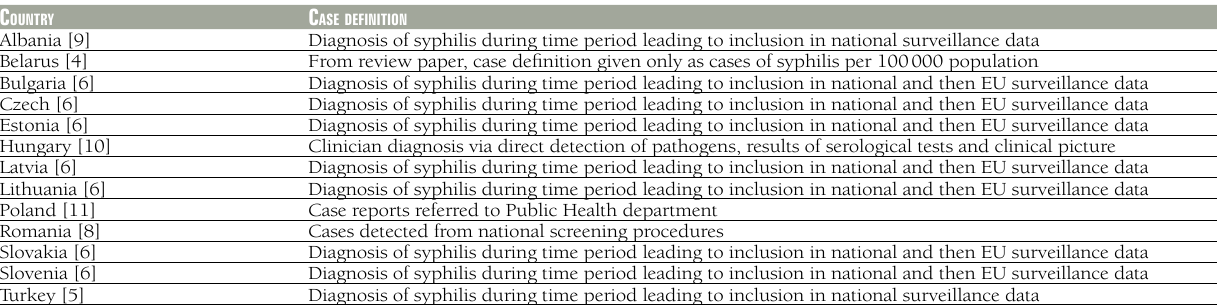
Table 2 Case definitions of syphilis cases from included